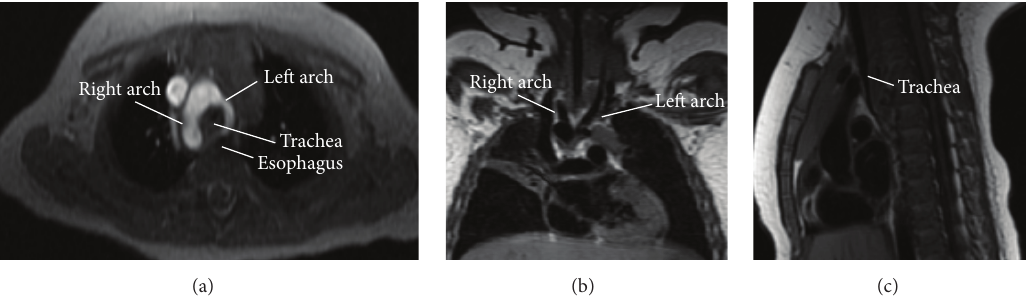
Figure 1: Contrast-enhanced magnetic resonance angiography demonstrating the double aortic arch with dominant right arch as demonstrated on axial (a), coronal (b), and sagittal planes (c). The axial and sagittal images reveal that the trachea and esophagus are surrounded and compressed by a vascular ring formed by the double aortic arch. The coronal image demonstrates that the right arch is larger and higher in position than left counterpart, which is